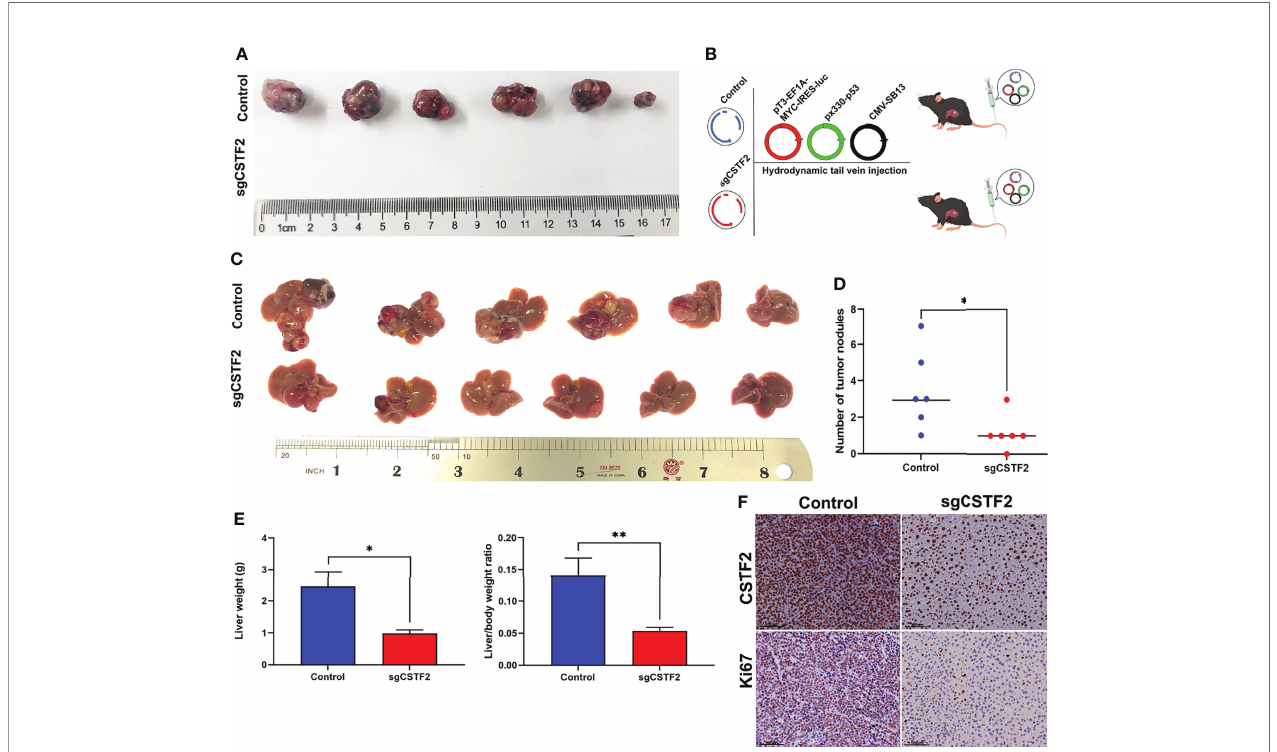
FIGURE 7 | Knockout of CSTF2 inhibited the tumorigenesis and progression of HCC. (A) In vivo tumor formation of CSTF2 sgRNA Huh7 and vector control Huh7. Tumorigenesis experiments were performed by subcutaneously injecting Huh7 cells into BALB/c nude mice. (B) Strategy for evaluating the hepatocarcinogenesis function of CSTF2 in immunocompetent C57BL/6 mice. Schematic representation of the hydrodynamic tail vein injection HCC model. Plasmids pT3-EF1A-MYC- IRES-luc, px330-p53 (p53-sgRNA), and CMV-SB13 transposase were delivered together with either CSTF2 sgRNA (sgCSTF2) or the control vector for HCC induction. (C) Representative images of dissected livers in CSTF2 sgRNA and the vector control group. (D) The number of tumor nodules in mice injected with sgCSTF2 was signi fi cantly lower than that in the control group. (E) Quali fi cation of the liver weight, and the ratio of liver weight to body weight of these tumor nodules in CSTF2 sgRNA or control groups. At least 6 mice were used in every group. (F) Immunohistochemical staining formed tumors in the liver tissues using CSTF2 and Ki67 antibodies. Scale bar, 100 m m. sgCSTF2 represents CSTF2-sgRNA. The empty vector of sgRNA was used as control. * r < 0.05, ** r < 0.01 compared to